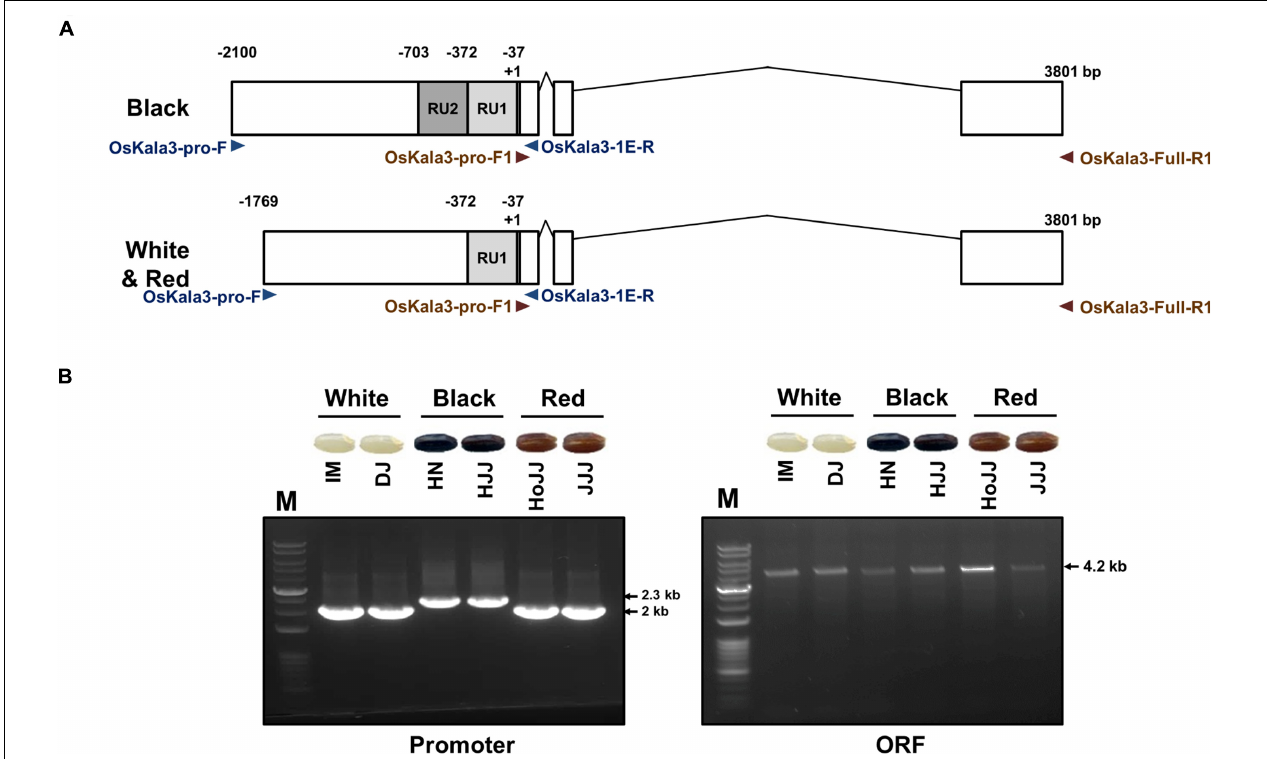
FIGURE 5 | Validation of OsKala3 promoter variation. (A) Diagram of the genomic structure of OsKala3 from black, red, and white pericarp cultivars. The light gray box and dark gray box indicate repeat unit 1 (RU1) and RU2, respectively, in the OsKala3 promoter region. (B) The amplicons’ representative gel image corresponds to promoter region (left) and ORF region (right). The primers used in this study are shown as arrows and listed in Supplementary Table 1 .